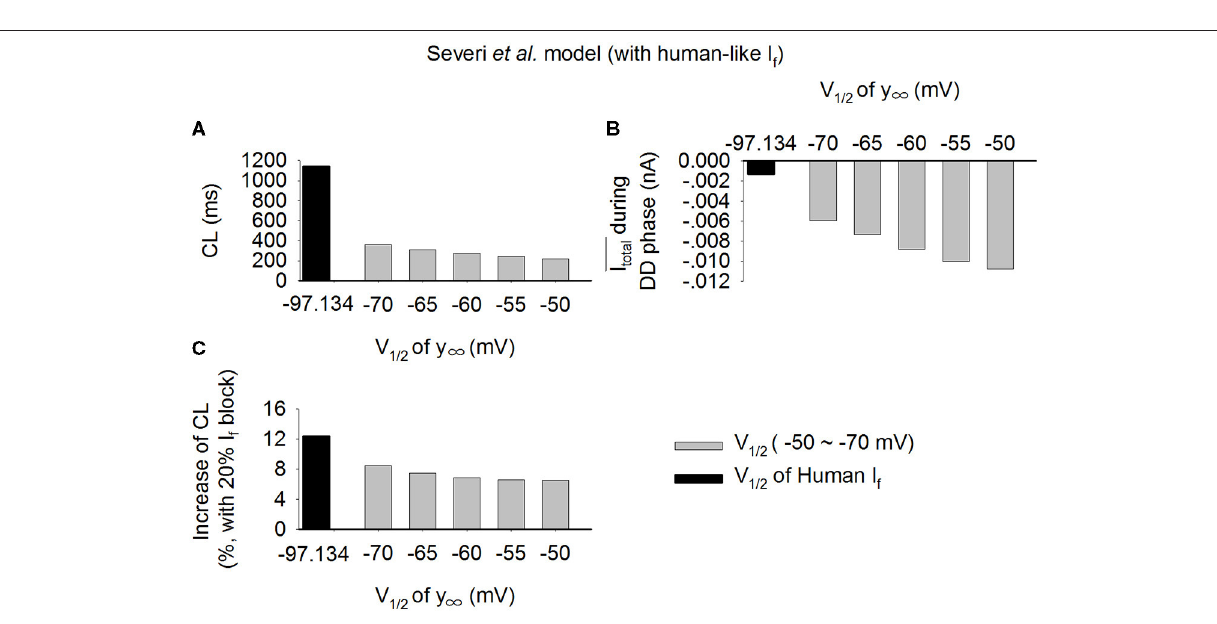
FIGURE 9 | (A–C) Effect of varied half-activation voltage ( V 1 / 2 ) of the steady state activation variable (y ∞ ) on pacemaking CL in the Serveri et al. model with human-like